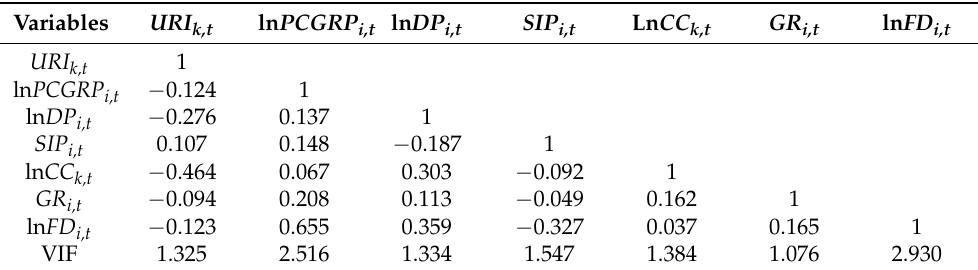
Table 2. Correlation matrix and variance inflation factor (VIF) among the control variables.